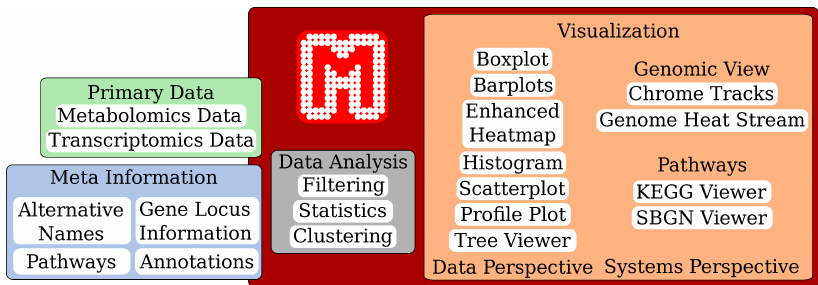
Figure 1: Visualization concept of M AYDAY . M AYDAY combines various analytical and visualiza- tion methods, working on a wide range of data. For details on the different views and concepts, see